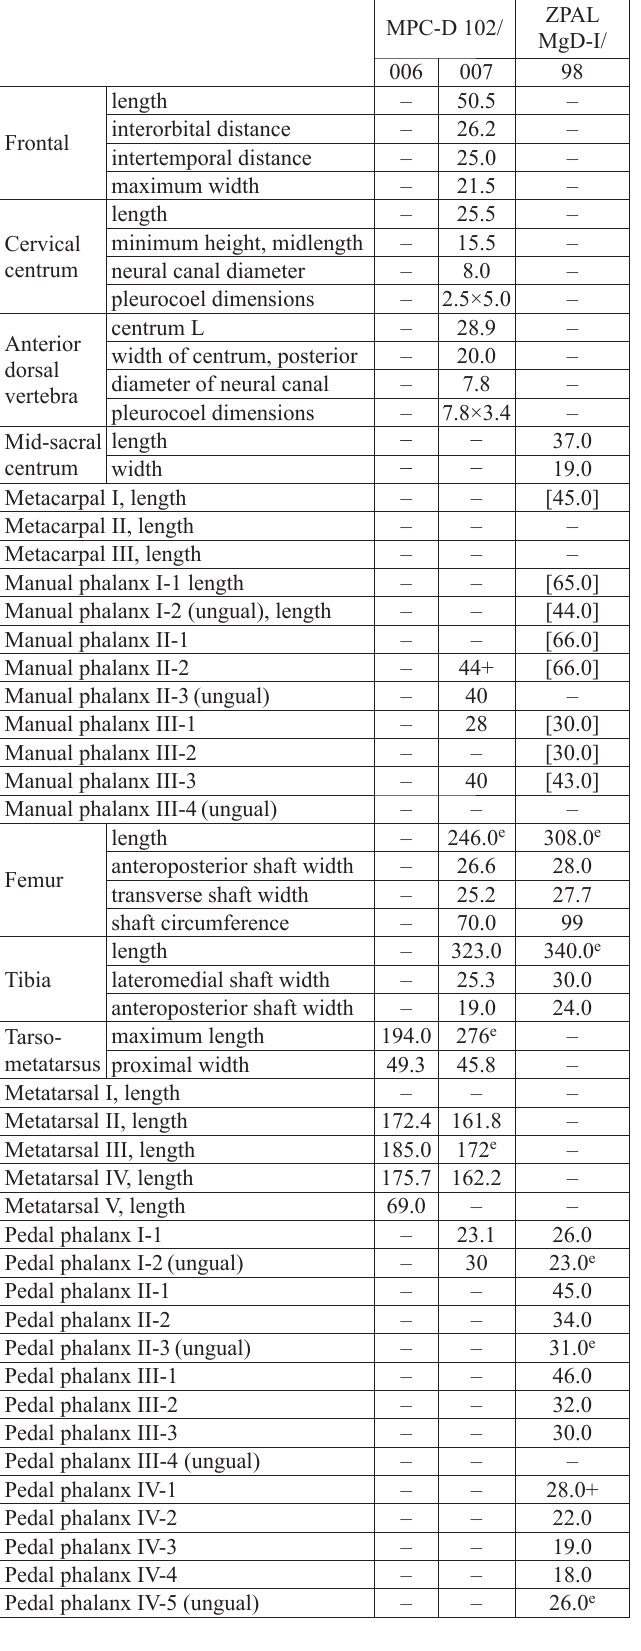
Table 1. Measurements (in mm) of Elmisaurus rarus. Square brackets, measurements previously published by Osmólska (1981); e ,